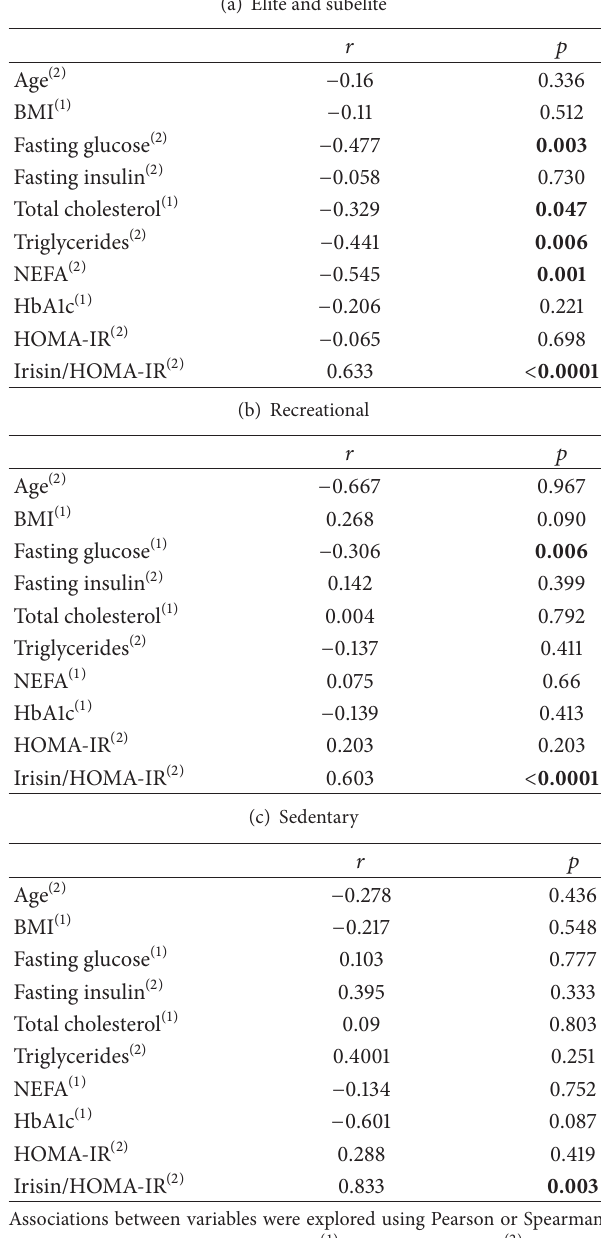
Table 1: Univariate association between plasma irisin level and demographic, anthropometric, and biochemical parameters in dif- ferently trained individuals: (a) elite + subelite group, (b) recre- ational group, and (c) sedentary